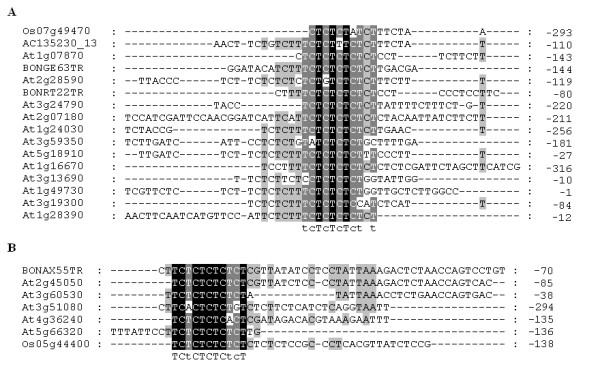
Conservation of microsatellites in plants. (A) Sequence alignments for the CNMS conserved among the homologous protein kinase genes from Arabidopsis, Brassica, Medicago and rice. Atlg07870, At2g28590, BONGE63TR, BONRT22TR, AC135230_13 and Os07g49470 are orthologs for the four species. Sequences of Medicago (AC135230_13) and rice (Os07g49470) obtained from TIGR plant genome sequence database. (B) Sequence alignments for the CNMS conserved among the homologous GATA transcription factor genes from Arabidopsis, Brassica and rice. BONAX55TR and At2g45050 are orthologs for Brassica and Arabidopsis. The homologous gene Os05g44400 from rice.